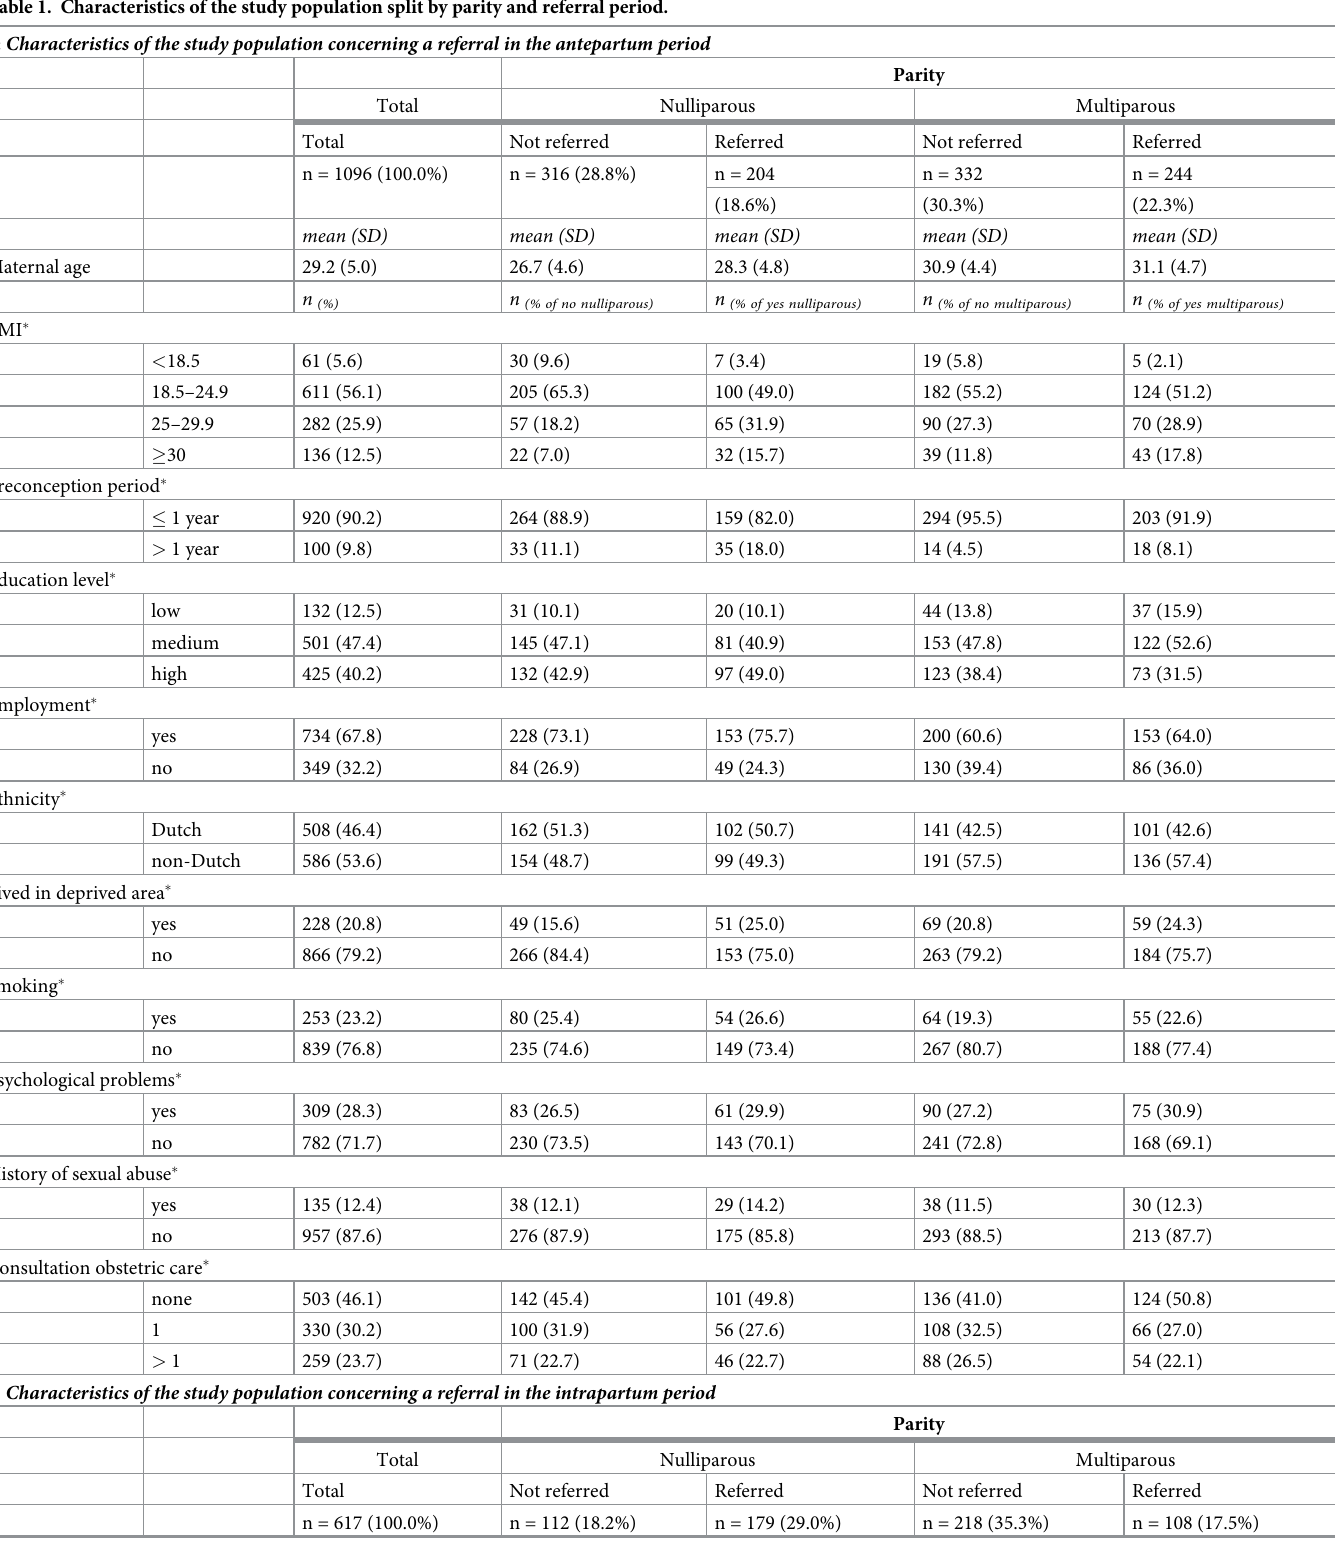
Table 1. Characteristics of the study population split by parity and referral period. a : Characteristics of the study population concerning a referral in the antepartum